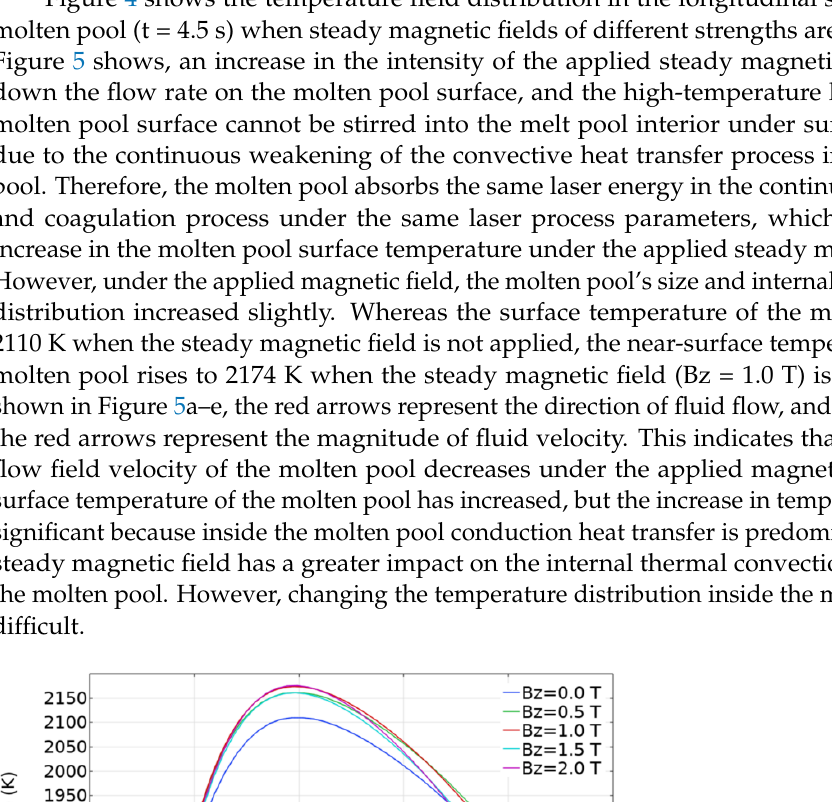
( d ) ( e ) Figure 5. Distribution of flow field at different magnetic field strengths (t = 4.5 s). ( a ) Bz = 0 T; ( b ) Bz = 0.5 T; ( c ) Bz = 1 T; ( d ) Bz = 1.5 T; and ( e ) Bz = 2 T.